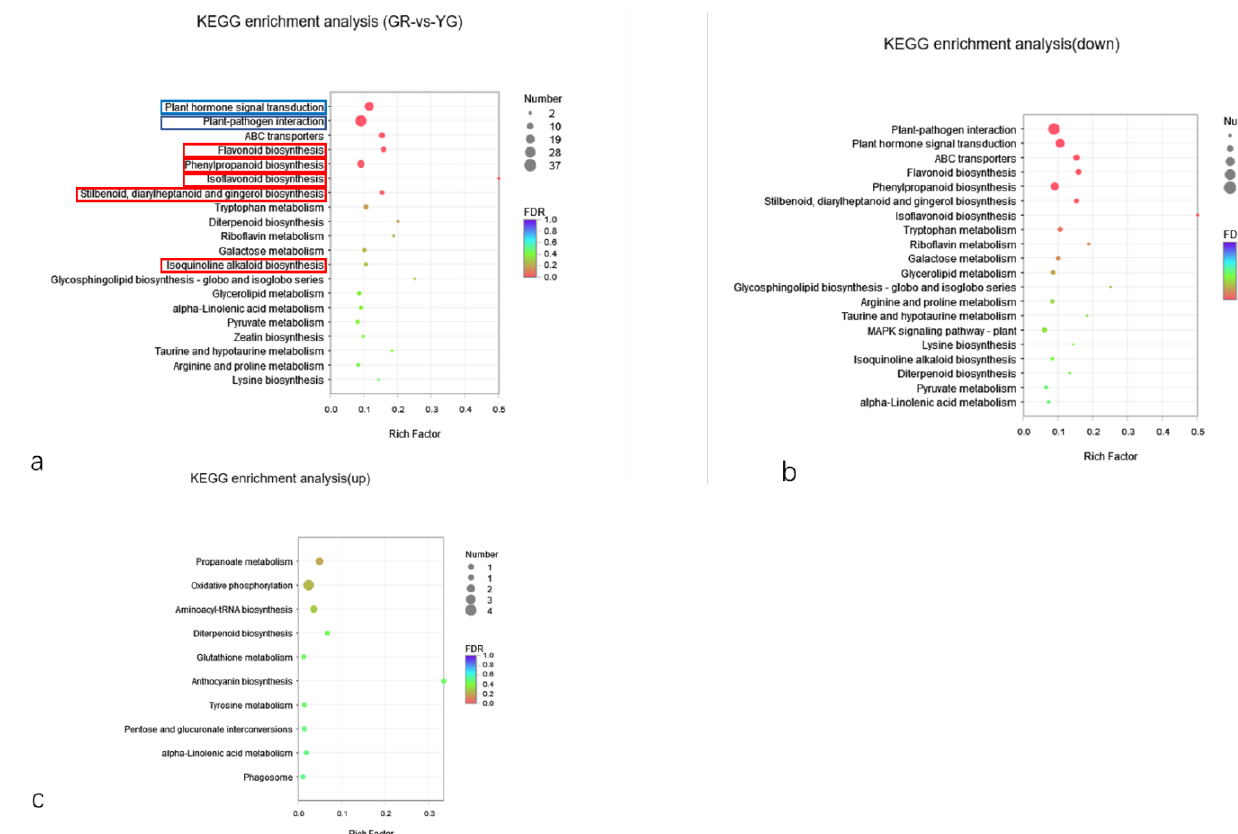
Figure 7. Scatter plot of enrichment factors in the KEGG pathways of DEGs. ( a ) KEGG enrichment bubble map. The blue box indicates the response to external stimuli and plant hormone signal transduction. The red box indicates the pathway of flavonoid synthesis. ( b ) KEGG enrichment bubble map of downregulated DEGs. ( c ) KEGG enrichment bubble map of upregulated DEGs. GR indicates the green region of the leaf, and YG indicates the yellow-green region of the